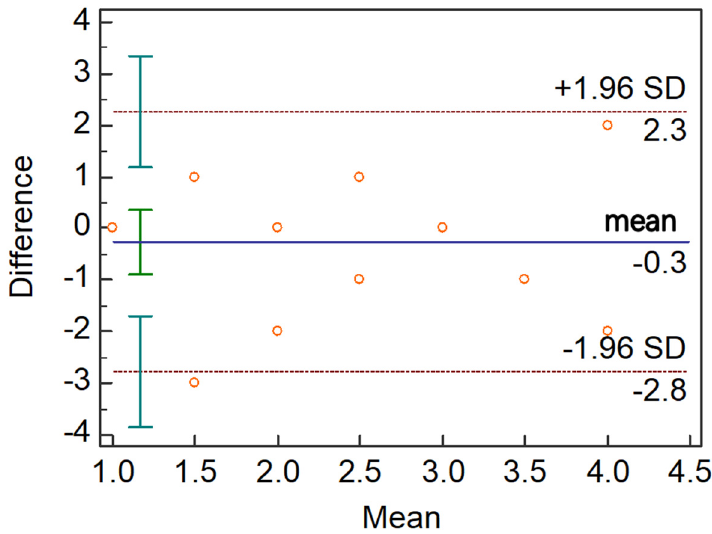
Figure 5. The Bland–Altman plots of intra-observer repeatability differences for UAS. The 95% LoA for UAS showed high agreement between the two measurements at different time points.